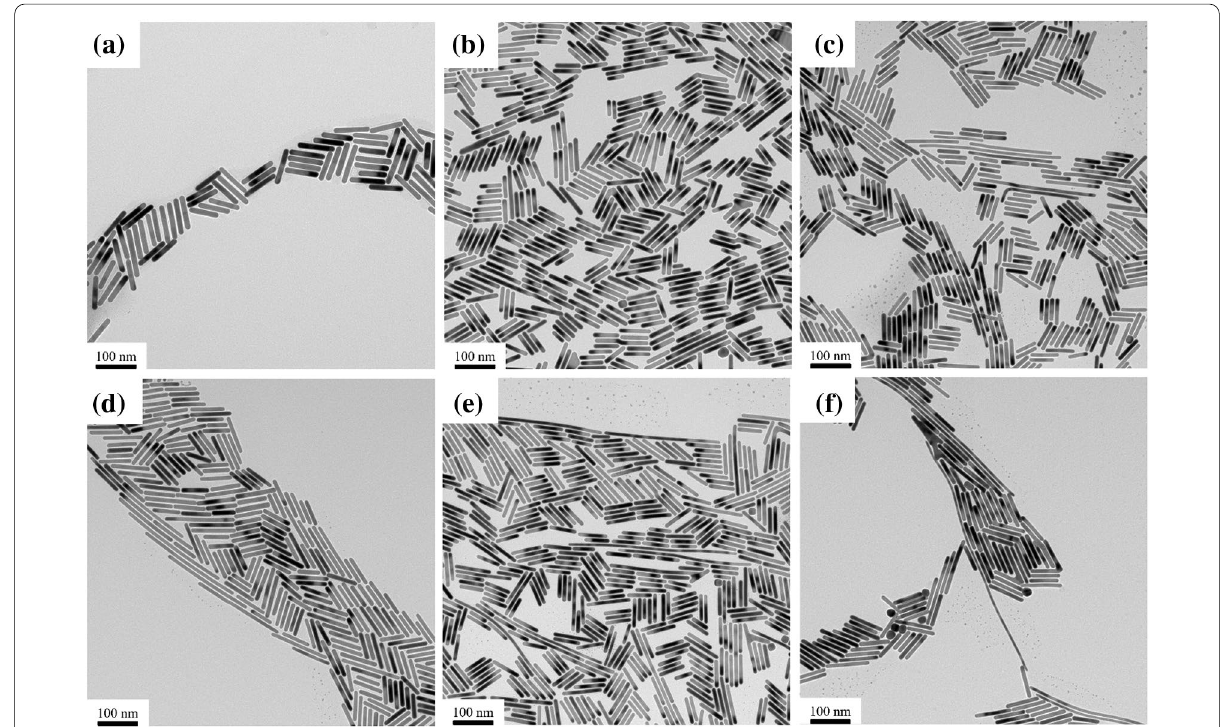
AA(0 μL), b HQ(240 μL) + AA(56 +